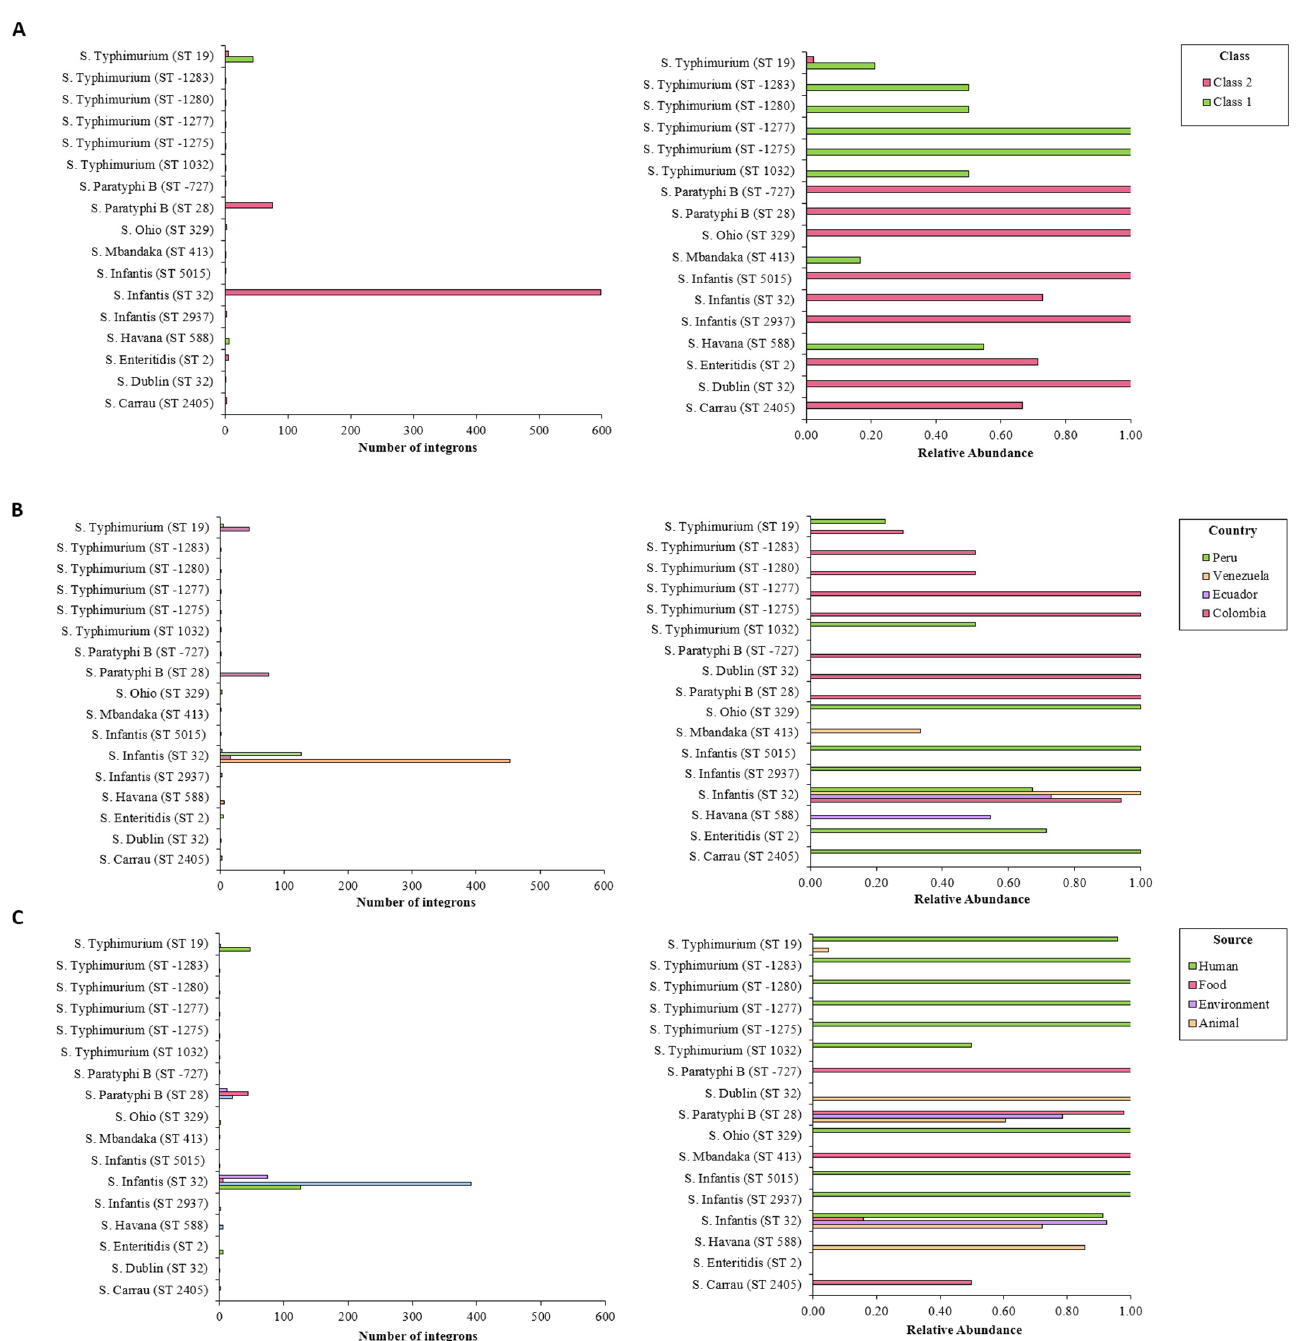
Figure 3. Number of integrons detected by IntFinder 1.0 according to sequence type, organized by ( A ) integron class, ( B ) source, and ( C ) country. Int , integrase.